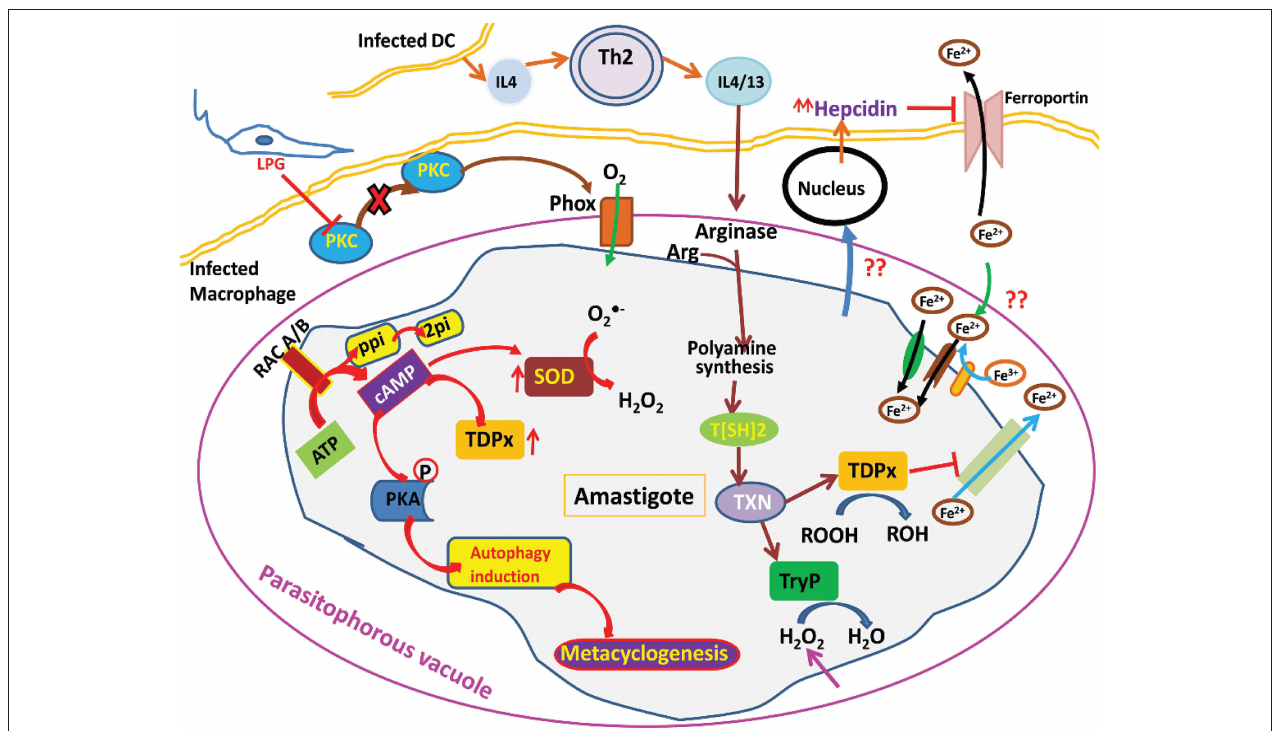
FIGURE 1 | Illustration of Leishmania parasite survival from oxidative